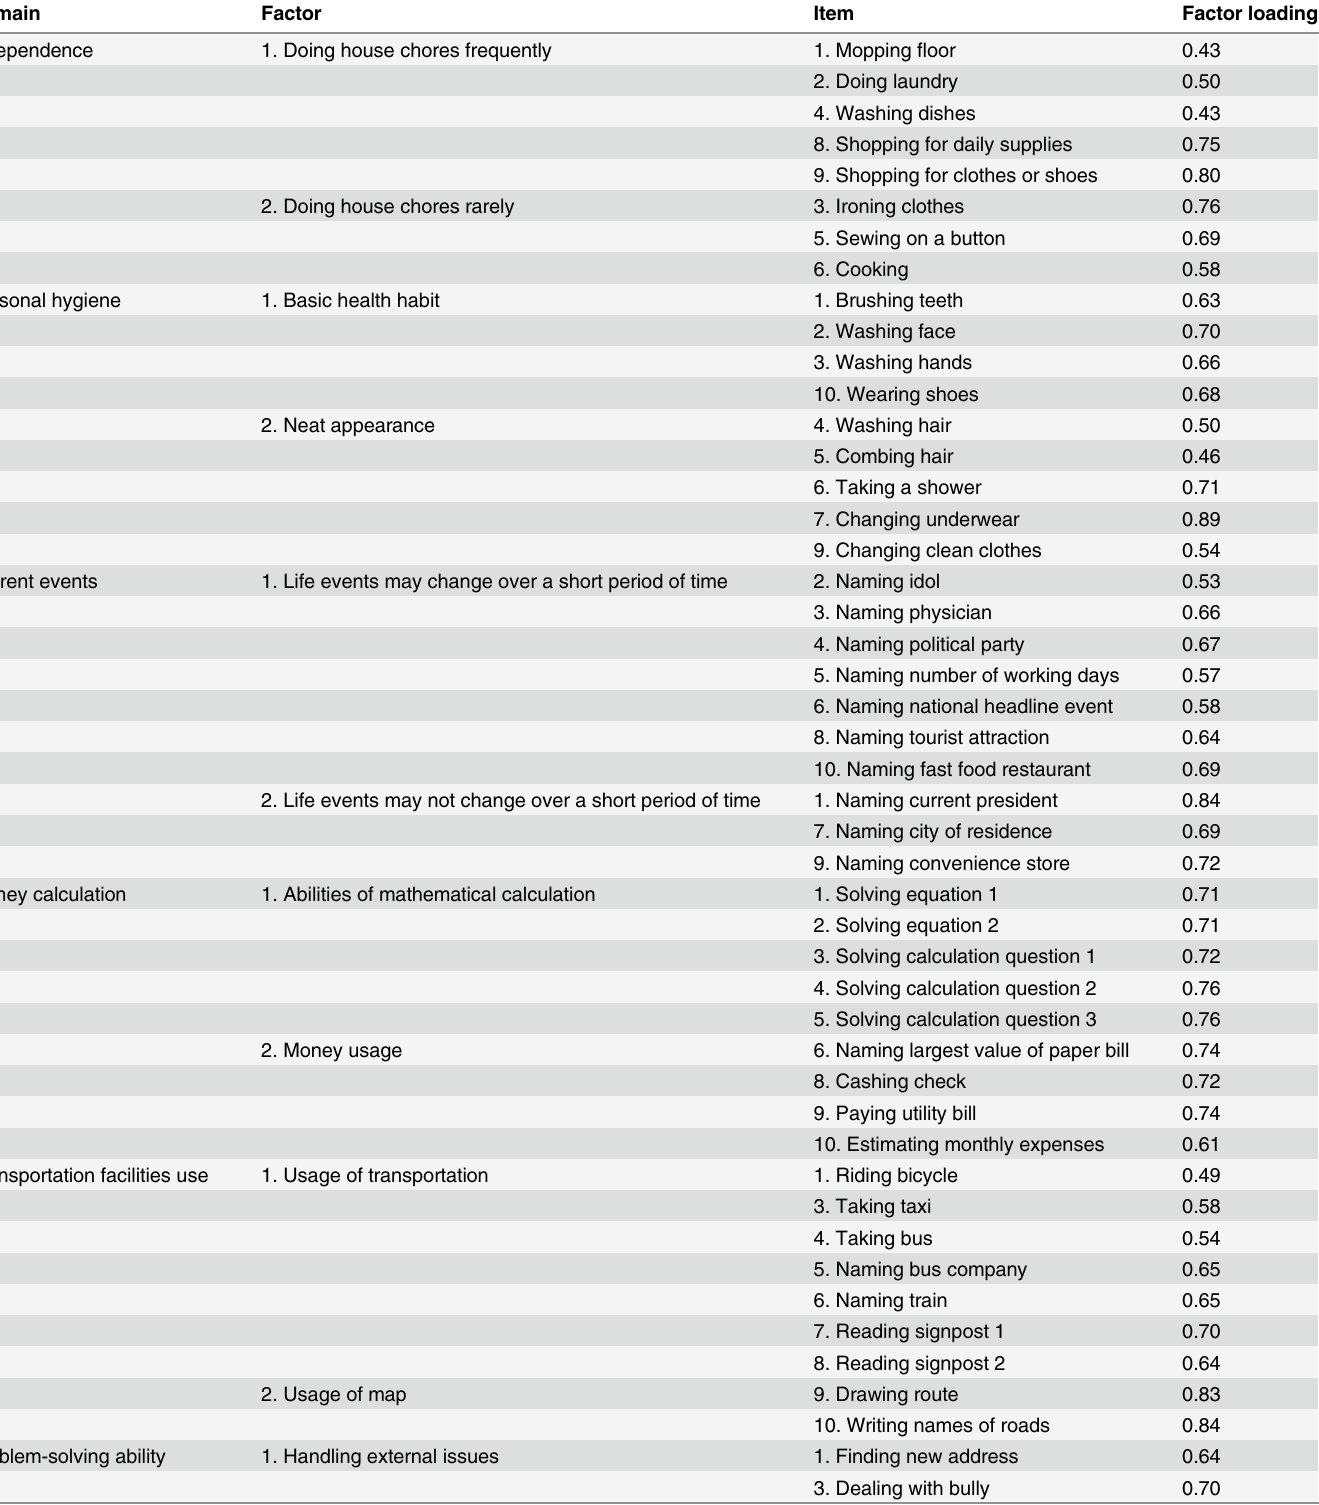
Table 3. Factor loadings of the 6 domains with two-factor structure using exploratory factor analysis.